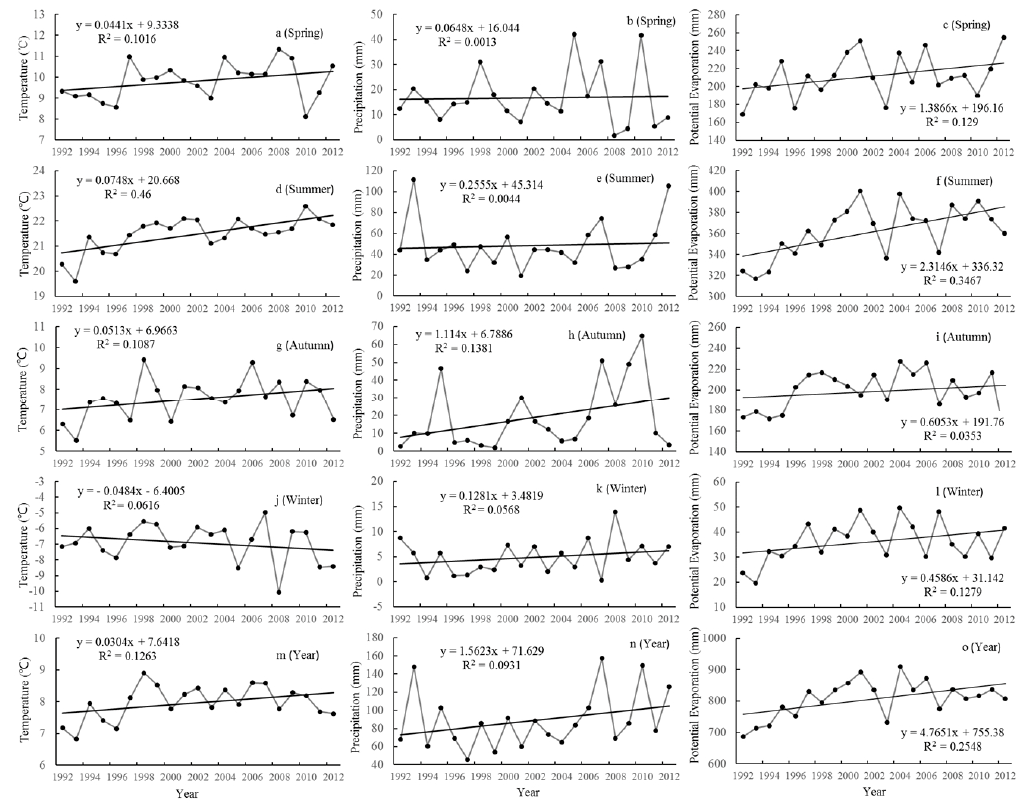
Figure 6. Variation of meteorological factors during 1992–2011 in arid inland river basin areas.